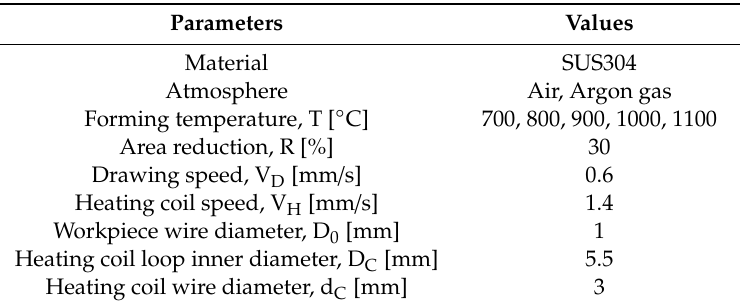
Table 1. Forming conditions for dieless wire drawing experiments.